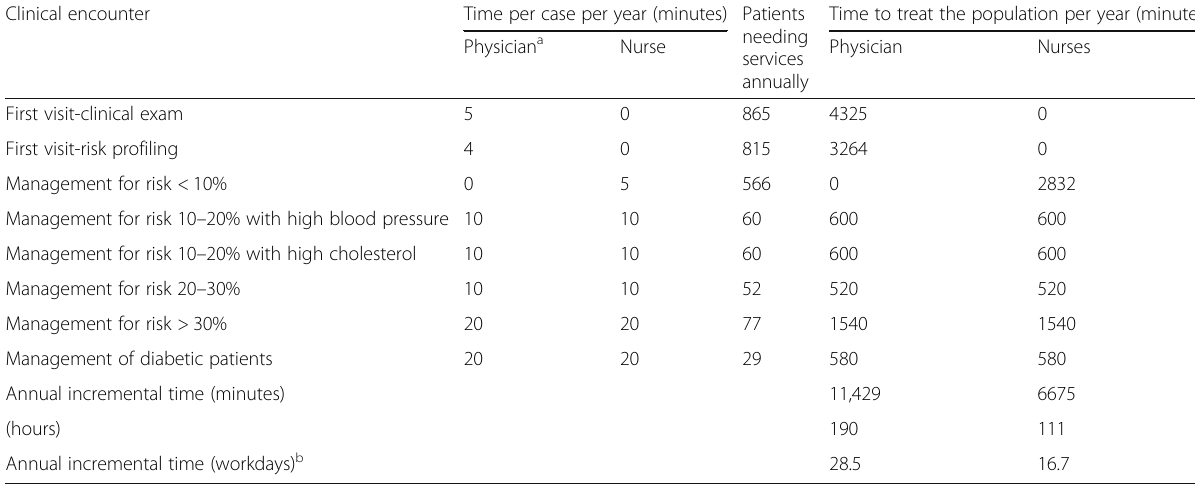
Table 4 Incremental time of healthcare providers in CVD management cases Clinical encounter